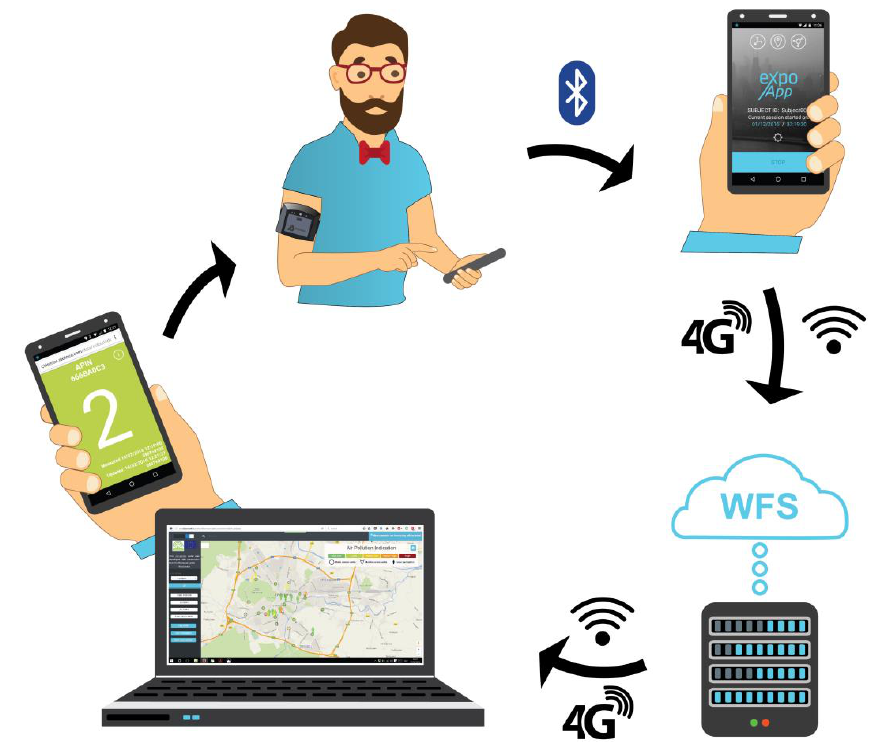
Figure 2. Data flow from the sensor system to the user via a smartphone and the server.